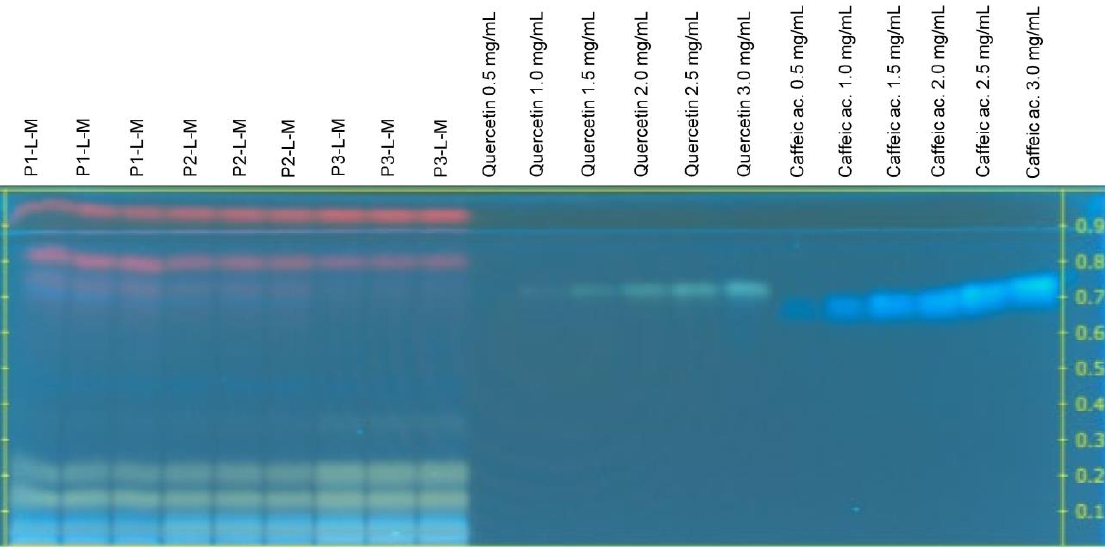
Figure 2. HPTLC chromatogram of ethanolic extracts from leaves of Cosmos sulphureus under visible light in the transmittance mode developed using ethyl acetate (100): formic acid (11): acetic acid (11):